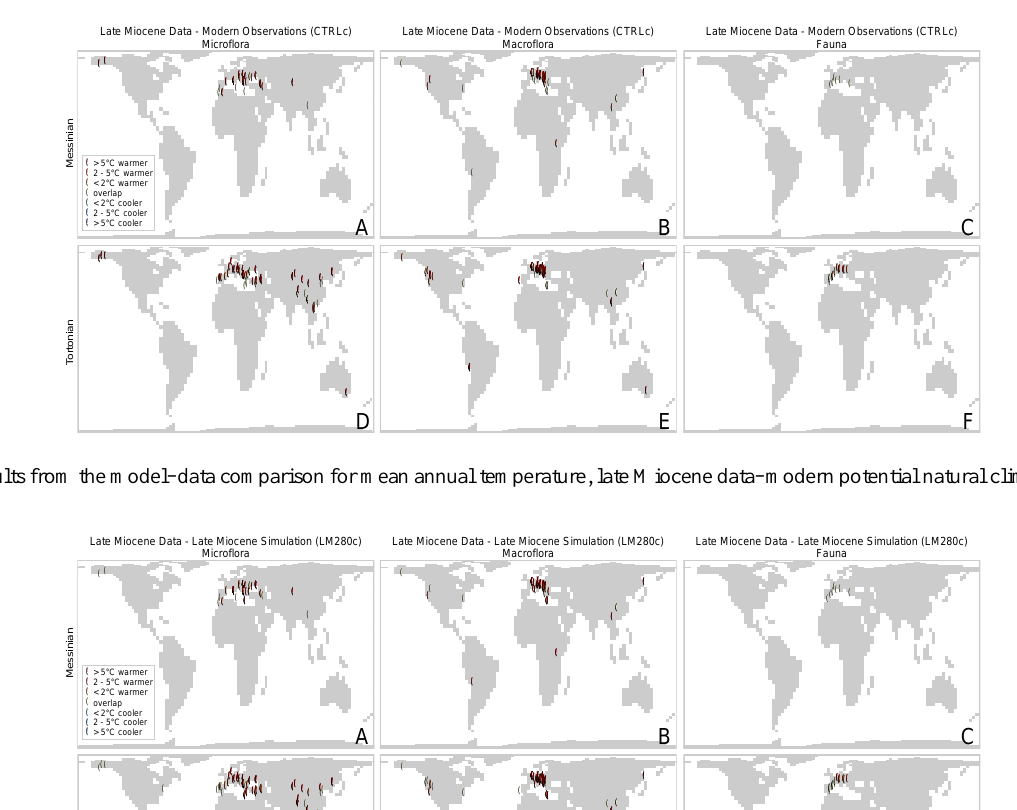
importance of CO 2 uncertainties in determining late Miocene